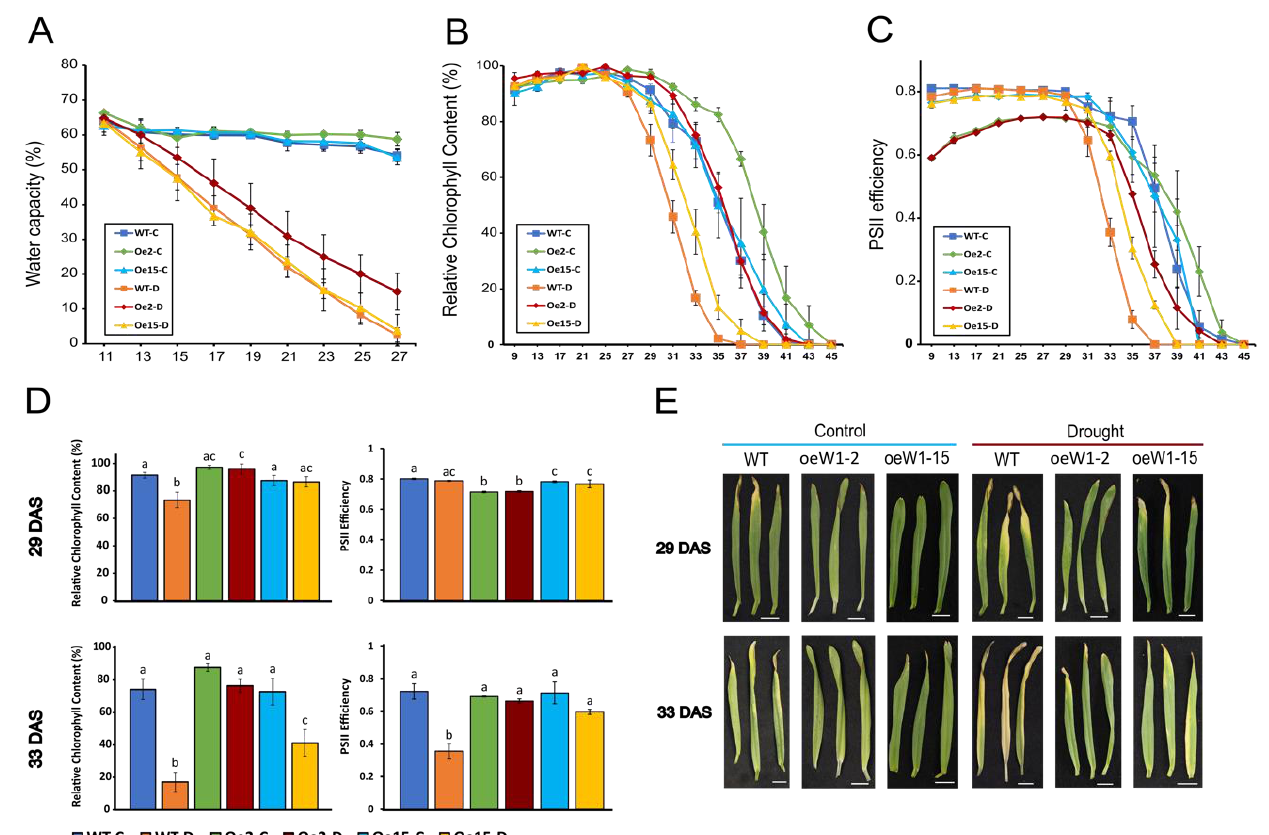
Figure 1. Changes in chlorophyll content and photosystem II efficiency in wild-type barley ( Hordeum vulgare cv. Golden Promise) (WT) and two WHIRLY1 overexpression lines (oeW1-2 and oeW1-15) under control (C) and drought (D) conditions (irrigation stopped at 11 das). ( A ) Soil water capacity. ( B , C ) Relative chlorophyll content (SPAD values) and PS II efficiency (F V /F M ) during drought treatment. ( D ) Relative chlorophyll content (SPAD values) and photosystem II efficiency (F V /F M ) at 29 and 33 das. Different letters above the graph bar designate statistically significant differences according to two-way ANOVA using Tukey’s HSD test with p < 0.05. ( E ) Senescence phenotype of the primary leaves from WT and oeW1 barley lines. Bars represent 1 cm. ( A – D ) Error bars show the standard deviation (SD) of the corresponding value.